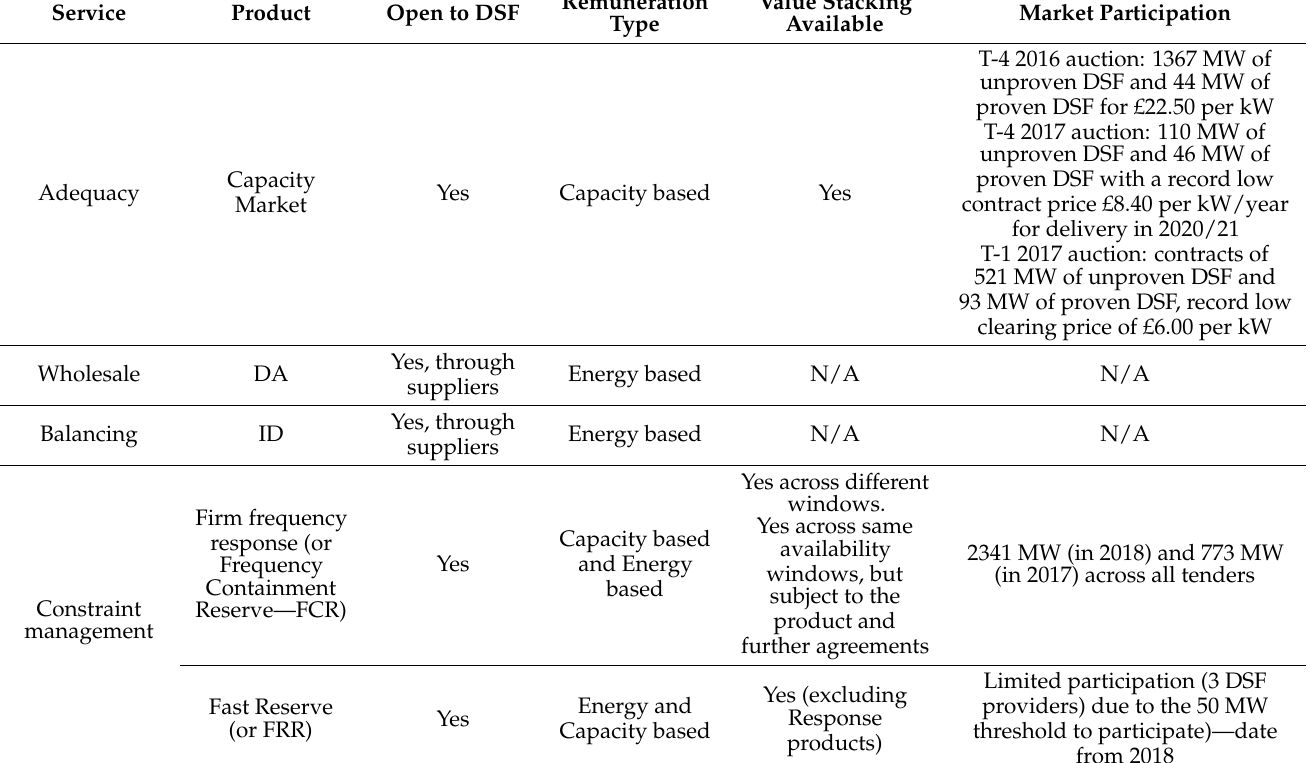
Table 1. UK’s electricity market services and demand side flexibility (DSF)